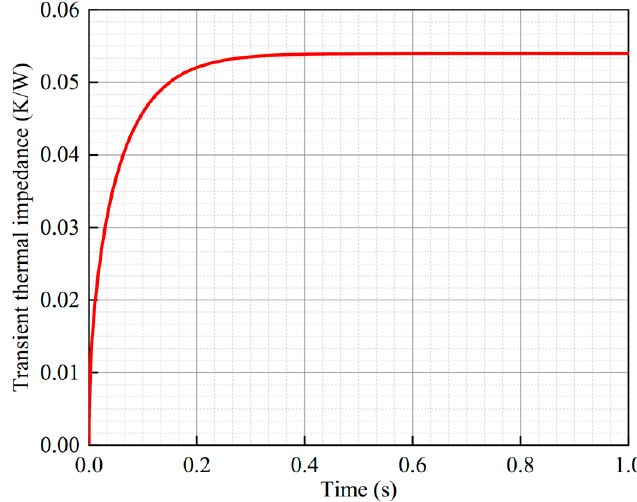
Figure 5. Configuration of the transient thermal impedance curve test.